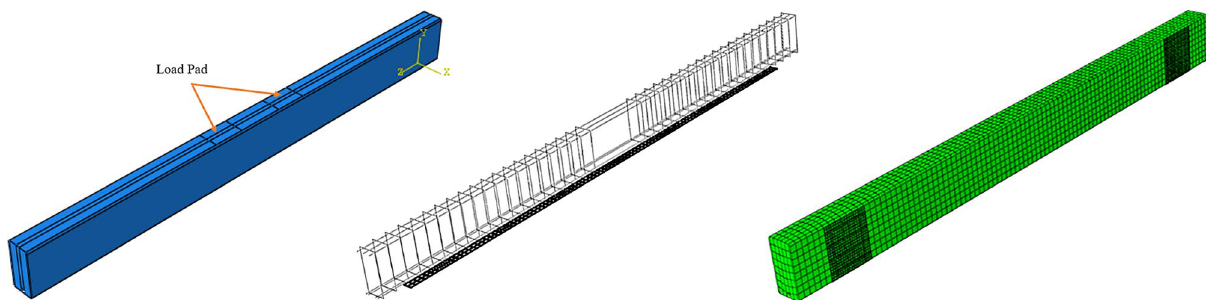
Figure 13. FEM model of prestressed beam